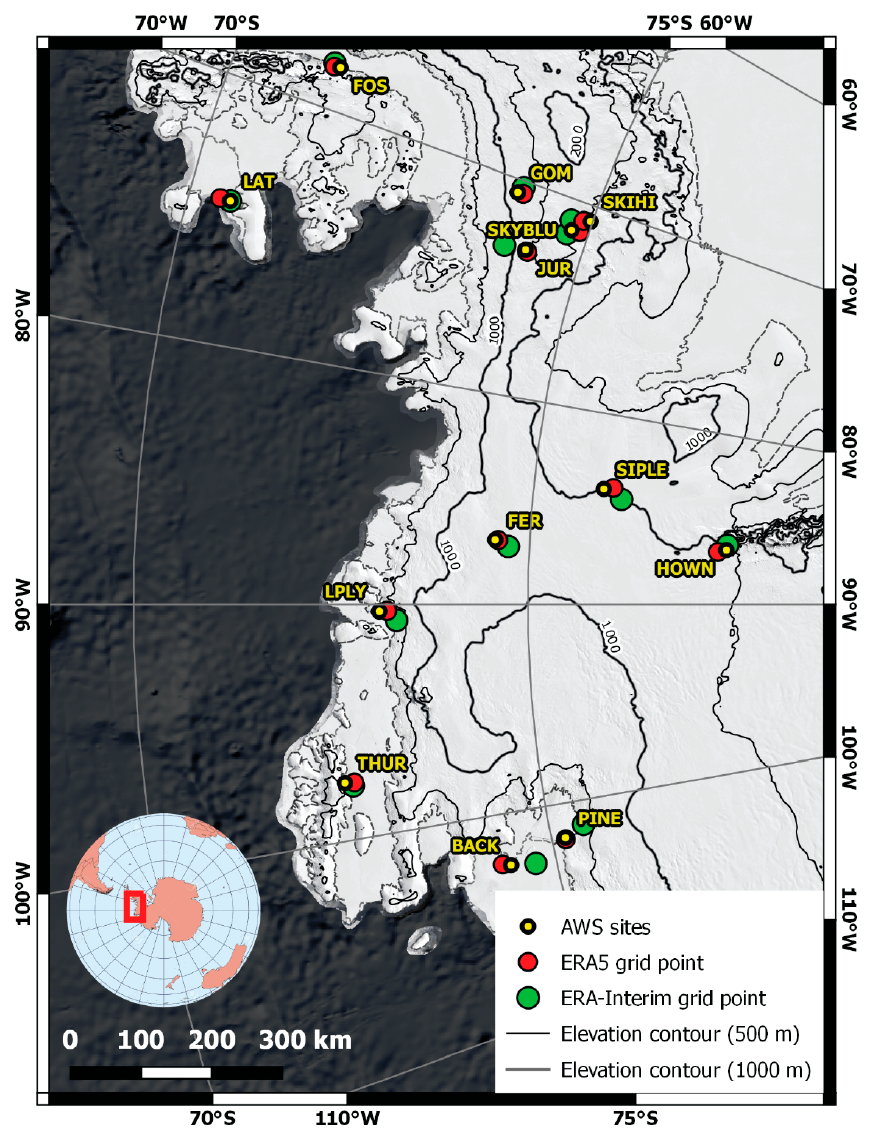
Figure 1. Map showing the automatic weather stations (AWS) sites considered in this study and their closest ERA-Interim and ERA5 grid points. The yellow circles show the locations of the thirteen AWS sites, Fossil Bluff (FOS), Latady Island (LAT), Gomez (GOM), Jurassic (JUR), Sky-blu (SKYBLU), Ski-Hi (SKIHI), Siple Station (SIPLE), Ferrigno (FER), Backer Island (BACK), Pine Island glacier (PINE), Thurston Island (THUR), Howard nunatak (HOWN), Lepley nunatak (LPLY).